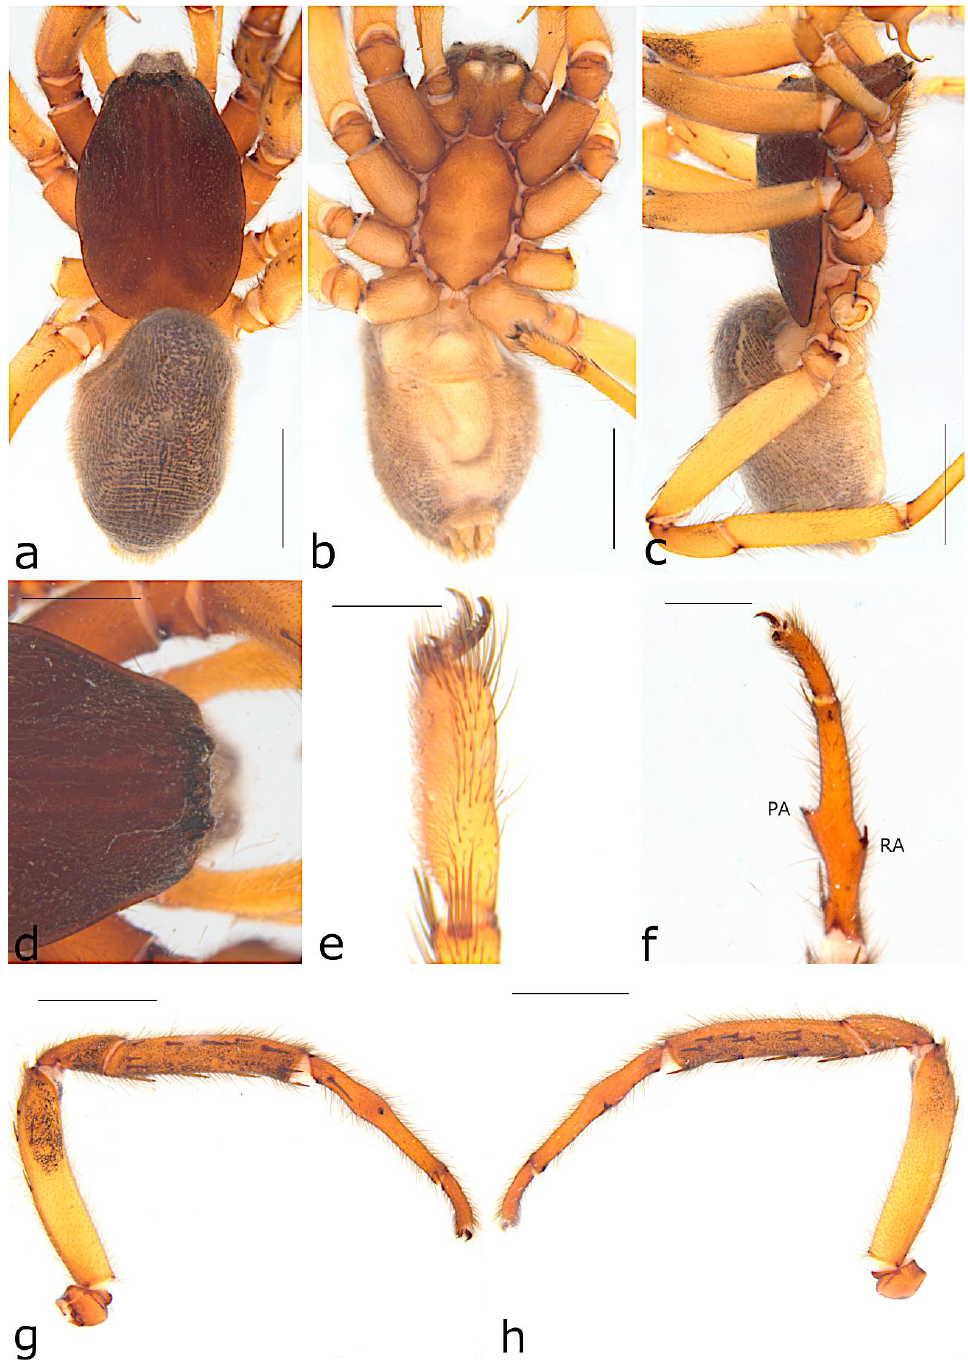
Figure 31. Ariadna curvata sp. nov. holotype (SAMA NN30589) from Arkaroola (SA): ( a ) habitus, ♂ dorsal view; ( b ) same, ventral view; ( c ) same, lateral view; ( d ) eyes, dorsal view; ( e ) left metatarsus IV, preening comb, retrolateral view; ( f ) left leg I, ventral view; ( g ) same, prolateral view; ( h ) same, retrolateral view. Scale bars ( a – c ) = 2 mm, ( d , f ) = 1 mm, ( e ) = 0.5 mm and ( g , h ) = 2